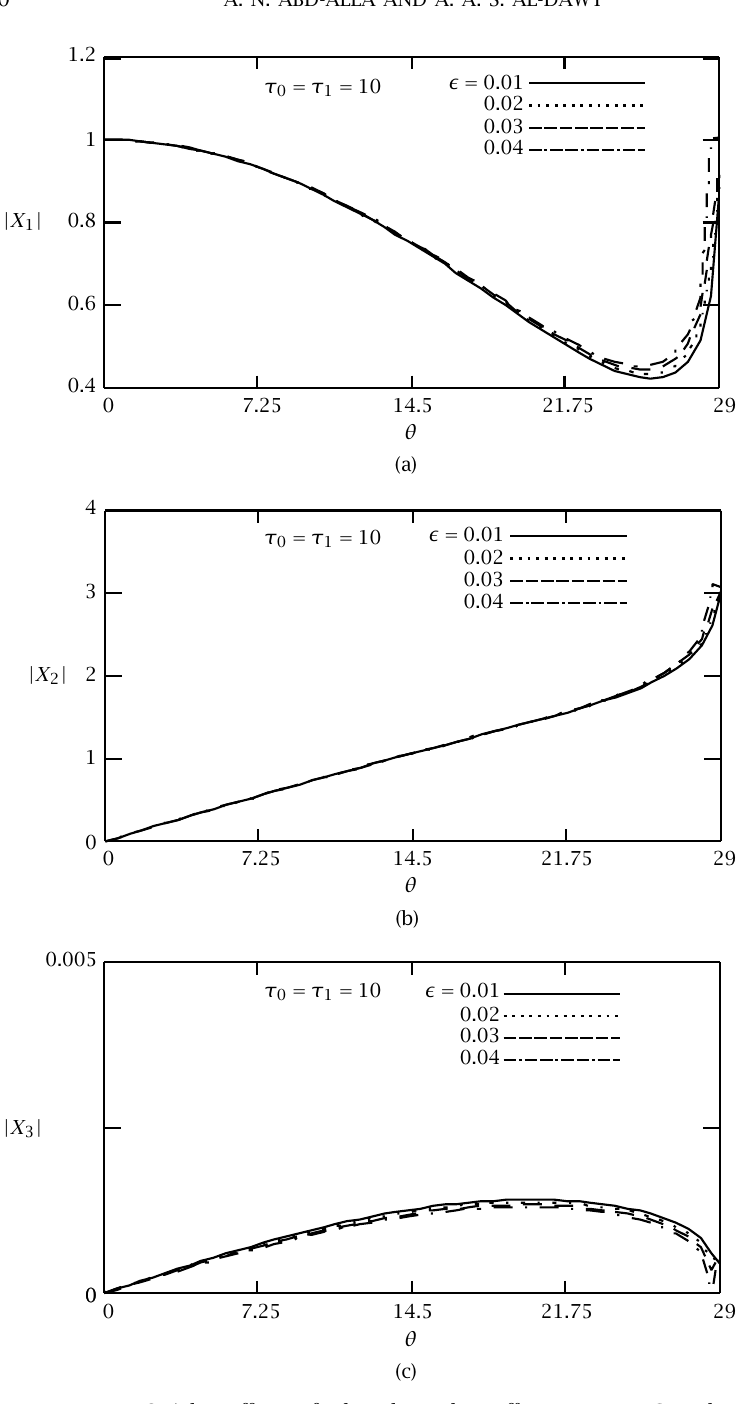
Figure 6 . (The effect of the thermal coefficient * in G-L theory) | X 1 | , | X 2 | , | X 3 | versus the angle of incidence θ